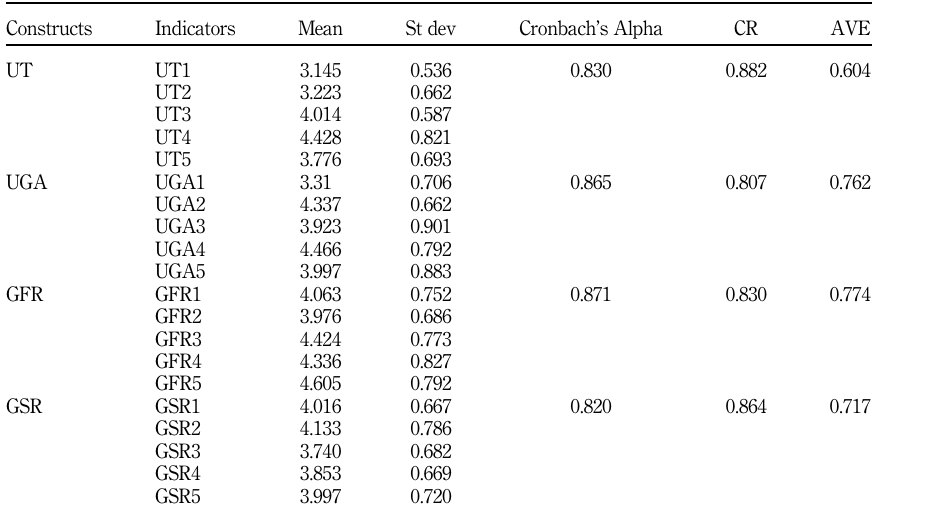
Figure 3. Reasons for not selecting the CGB